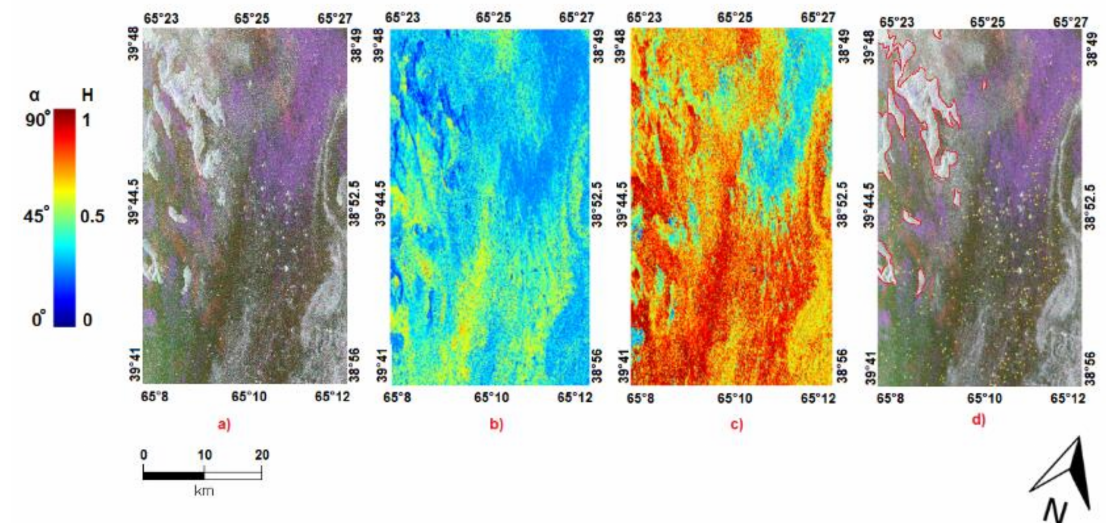
Figure 4. Output images for Isortoq, 15 August 2015 01:26, ( a ) Pauli RGB image, ( b ) alpha image in a 5 × 5 window, ( c ) entropy image in a 5 × 5 window, ( d ) visual identification of icebergs and land mask Yellow dots are icebergs. The red line represents the shoreline. Reprinted with permission from ref. [22] Copyright 2020 Remote Sensing.